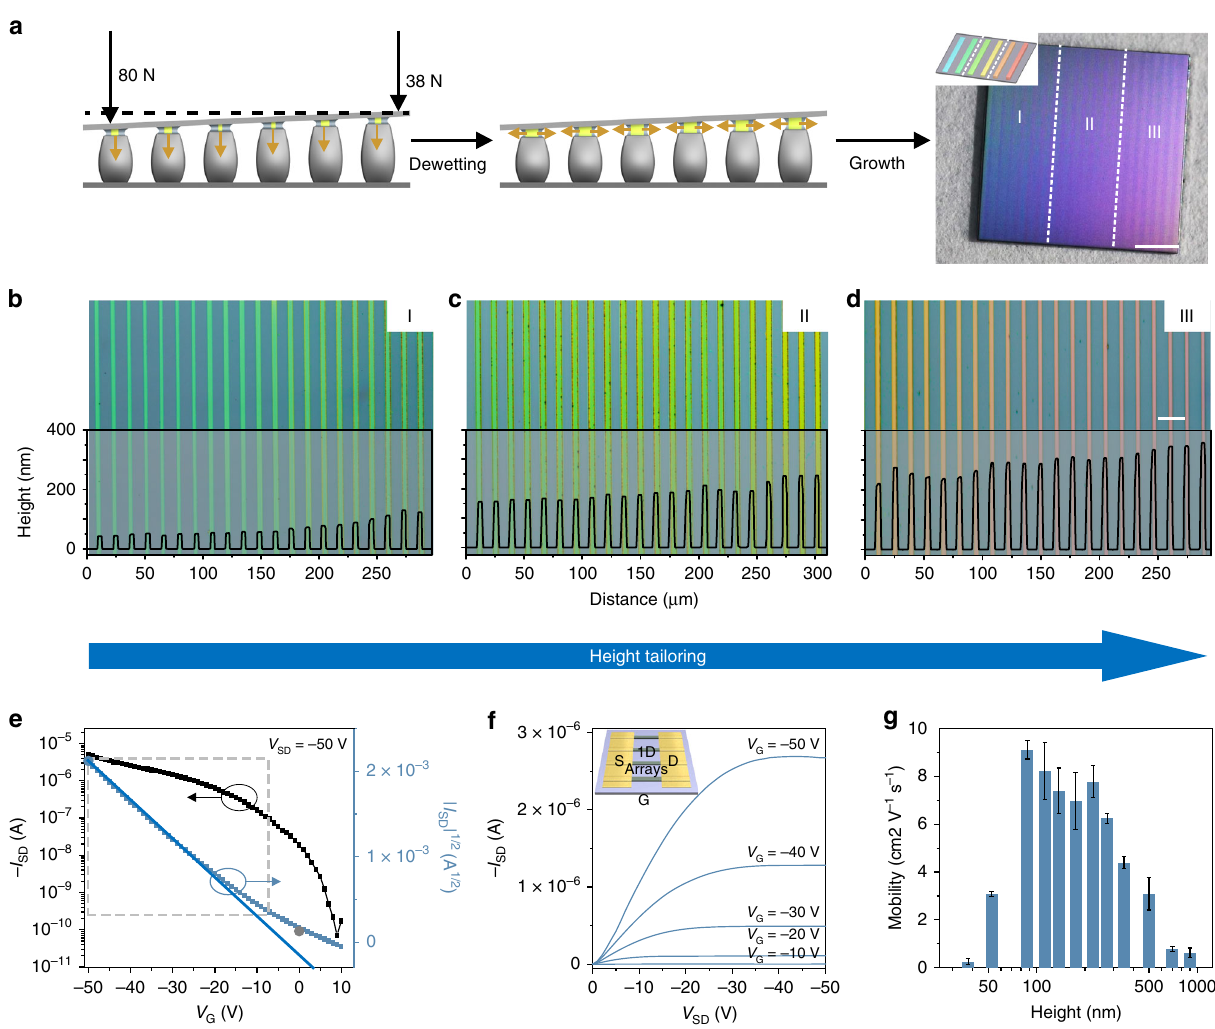
Fig. 4 Height tailoring of ultrathin 1D organic nanobelt arrays. a Nucleation (left) and growth (middle) of organic crystals in the nano-con fi ned space under linear gradient pressures. Digital photo showing the as-fabricated ultrathin nanobelt arrays with different sizes (divided into three areas as I, II, and III; right). b – d Typical optical micrographs of 1D arrays in the corresponding areas of I, II and III. Typical e output curve and f transfer curve of the device based on 1D arrays. The inset of f is the scheme of 1D array device (S: source electrode, D: drain electrode, and G: gate electrode). For the calculation of carrier mobility, the data in gray dash were employed, and the nattier blue and dark gray dots are marked as I distribution diagram of mobility corresponding with the height of belts. The columns in the diagram from left to right refer to the arithmetical mean of the mobility measured by ultrathin organic belts with the height range of <50, 50 – 75, 75 – 100, 100 – 125, 150 – 200, 200 – 250, 250 – 300, 300 – 400, 400 – 600, 600 – 800, and ≥ 800 nm. Scale bars: a 1 mm, d 20 μ